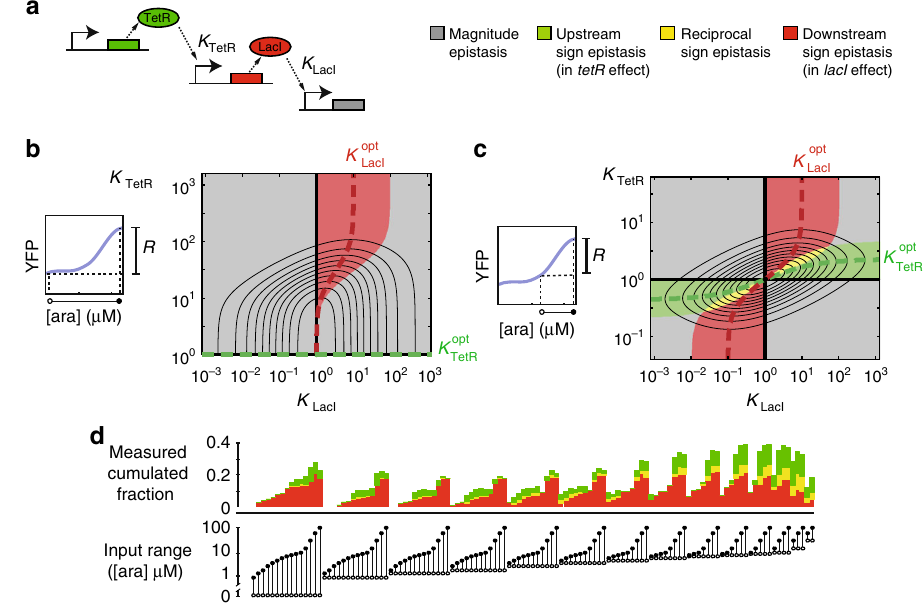
Fig. 3 Sign epistasis resulting from a biochemical model and environmental dependence. a Simpli fi ed diagram of biochemical model of the cascade. This model expresses the output response range R as a function of phenotypic parameters and input range (Methods section). Here we indicate K TetR and K LacI , the dissociation constants of each repressor to their operators, but other parameters like Hill coef fi cients are also considered. Mutations affect either the TetR or the LacI parameters. b Theoretical prediction of R using the biochemical cascade model (Methods section), for the full 0 – 100 µ M arabinose input range, as a function of K TetR and K LacI . Other parameters like Hill coef fi cients are fi xed at experimentally observed values. Curved grey lines are the corresponding iso- R lines. The colour at a particular point indicates the type of epistatic interaction predicted between the phenotype at that point and the optimum phenotype, as in Fig. 2. This optimum is found at the intersection of the axis (black lines). The line K opt indicates the optimal K TetR value for fi xed TetR K K opt indicates the optimal K LacI value for fi xed K TetR . K opt is horizontal, resulting in no domain of upstream sign epistasis. K opt is non-vertical, LacI . LacI LacI TetR resulting in a domain of downstream sign epistasis (red). c Same as b , with R being computed for a restricted 50 – 100 µ M arabinose input range. Here, the red domain is preserved, while additional green and yellow domains (upstream and reciprocal sign epistasis) are introduced, which is consistent with the empirical data ( d ). d Top: stack histogram of empirical epistasis fractions for different input ranges, as determined from the data in Fig. 1c. Each vertical stack corresponding to a different input range. Bottom: corresponding input ranges (open circle: minimum input; full circle: maximum input). The data shows that green and yellow is added to the red fraction, consistent with the predictions ( c